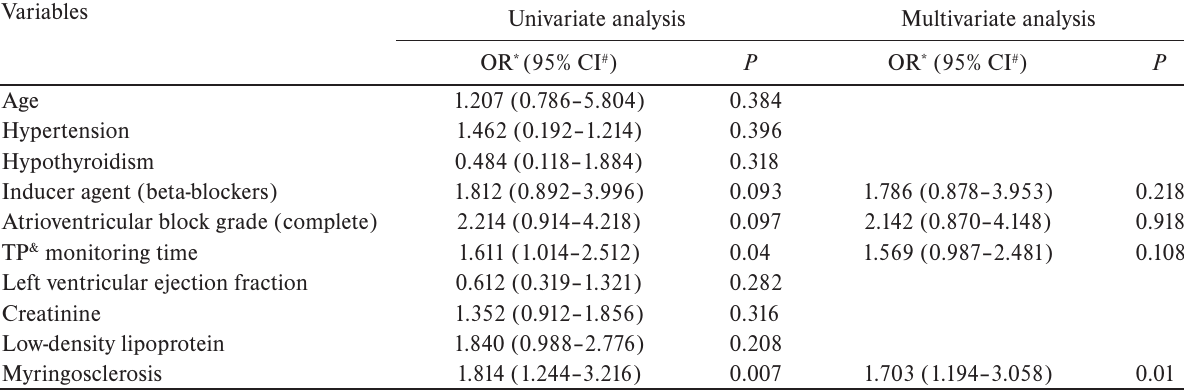
Table 2. Logistic regression analysis to assess predictors of irreversible high-grade atrioventricular block